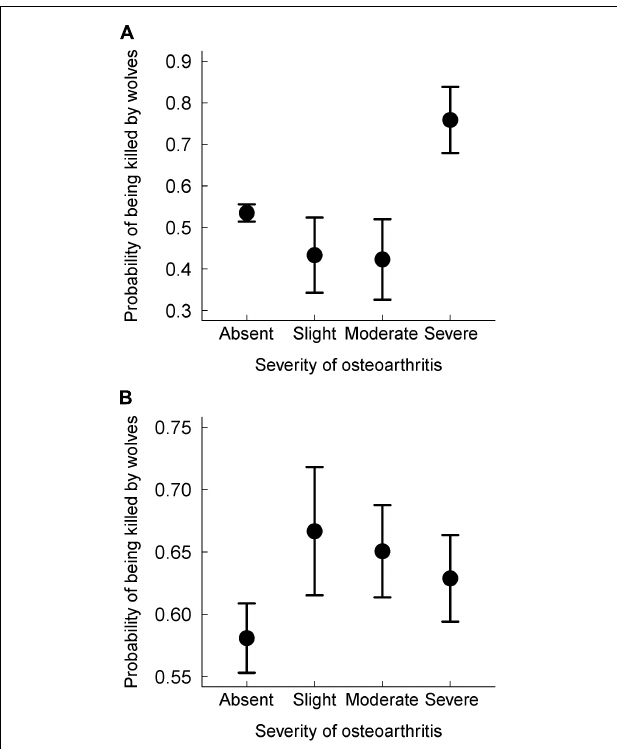
FIGURE 3 | Proportion of moose killed by wolves (as opposed to dying from other causes, i.e., starvation or accidents) varies with the severity of osteoarthritis for prime-aged moose (A) but not for senescent moose (B) . Moose were considered to be in their “prime” if they died between 1–9 years old or senescent if they died > 9 years old. Bars represent standard errors. Analysis is based on necropsies of 1,416 moose in Isle Royale National Park between 1959–2007 and for whom age-at-death, cause-of-death, and osteoarthritis status could be determined.